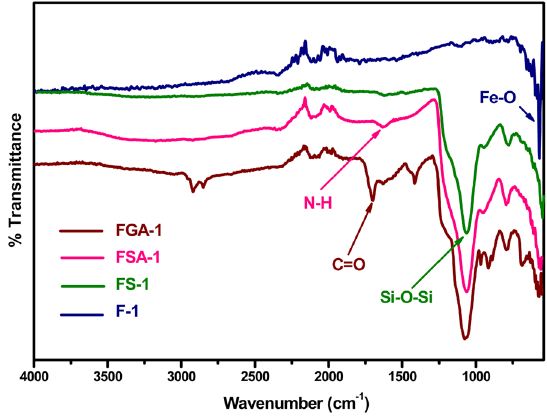
Figure 2. FTIR spectra of Fe 3 O 4 , silica coated, amine and acid functionalized